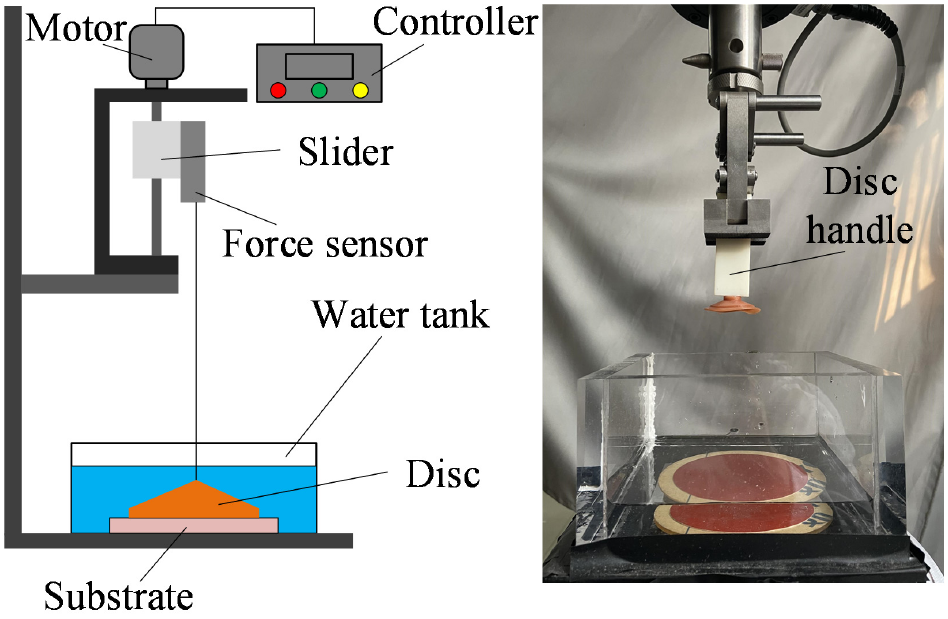
Figure 4. Contact force testing apparatus.